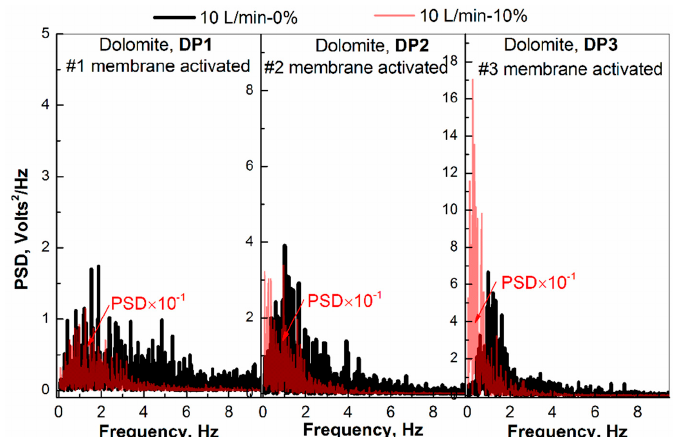
Figure 4. Comparison of the power spectra of the differential pressure in the local bed section measured at the gas extraction and normal operational conditions with the individual activation of membrane #1~3 for gas extraction. The other operational conditions were: T = 550 °C, P = 0.1 MPa, H ini = 1.28 m, U = 0.09 m/s, extraction rate = 1.5 L/min, calcined dolomite.